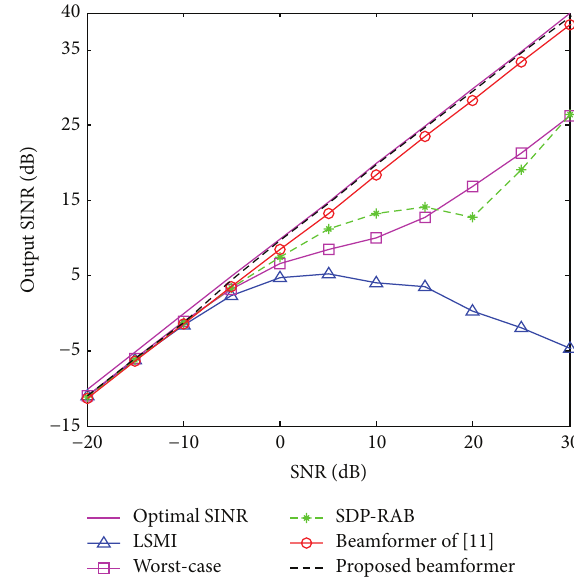
Figure 3: Output SINR versus the input SNR in the case of look direction